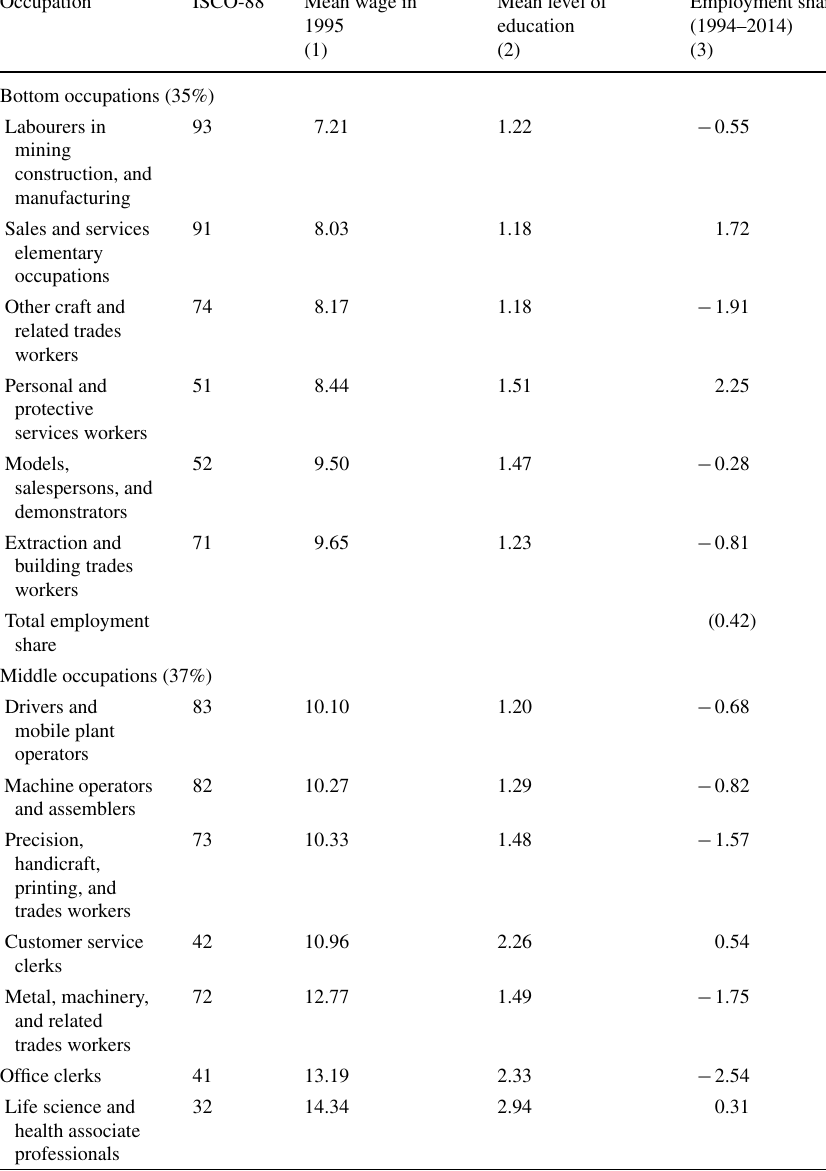
Table 5 Occupations,meanwage,andeducation. Sources :author’sanalysisfromtheSpanishLabourForce Survey (1994, 2014) and the Structure of Earnings Survey (1995)